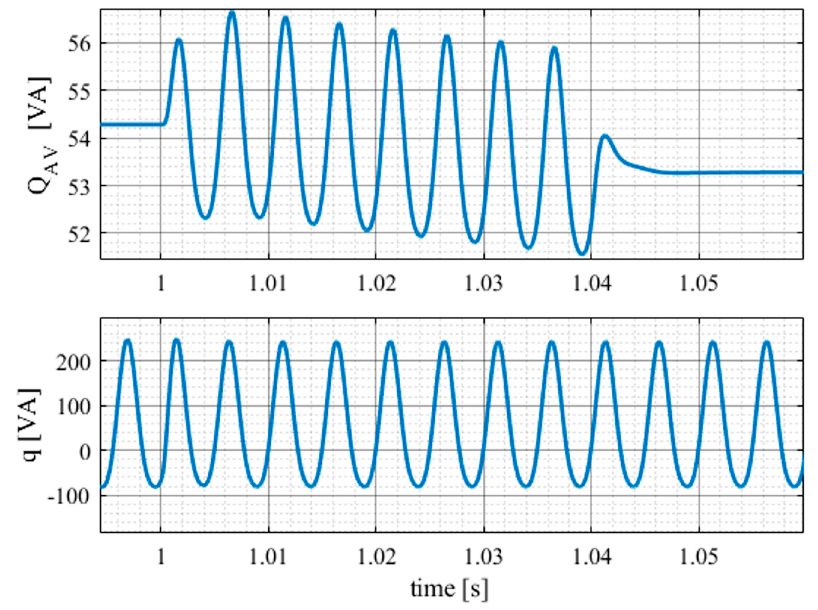
Figure 8. Time waveforms of 𝑄 (cid:3028)(cid:3049) and 𝑞 —case of compensation (top) 𝑄 (cid:3028)(cid:3049) during compensation (top), (bottom) 𝑞 during compensation (stays constant).